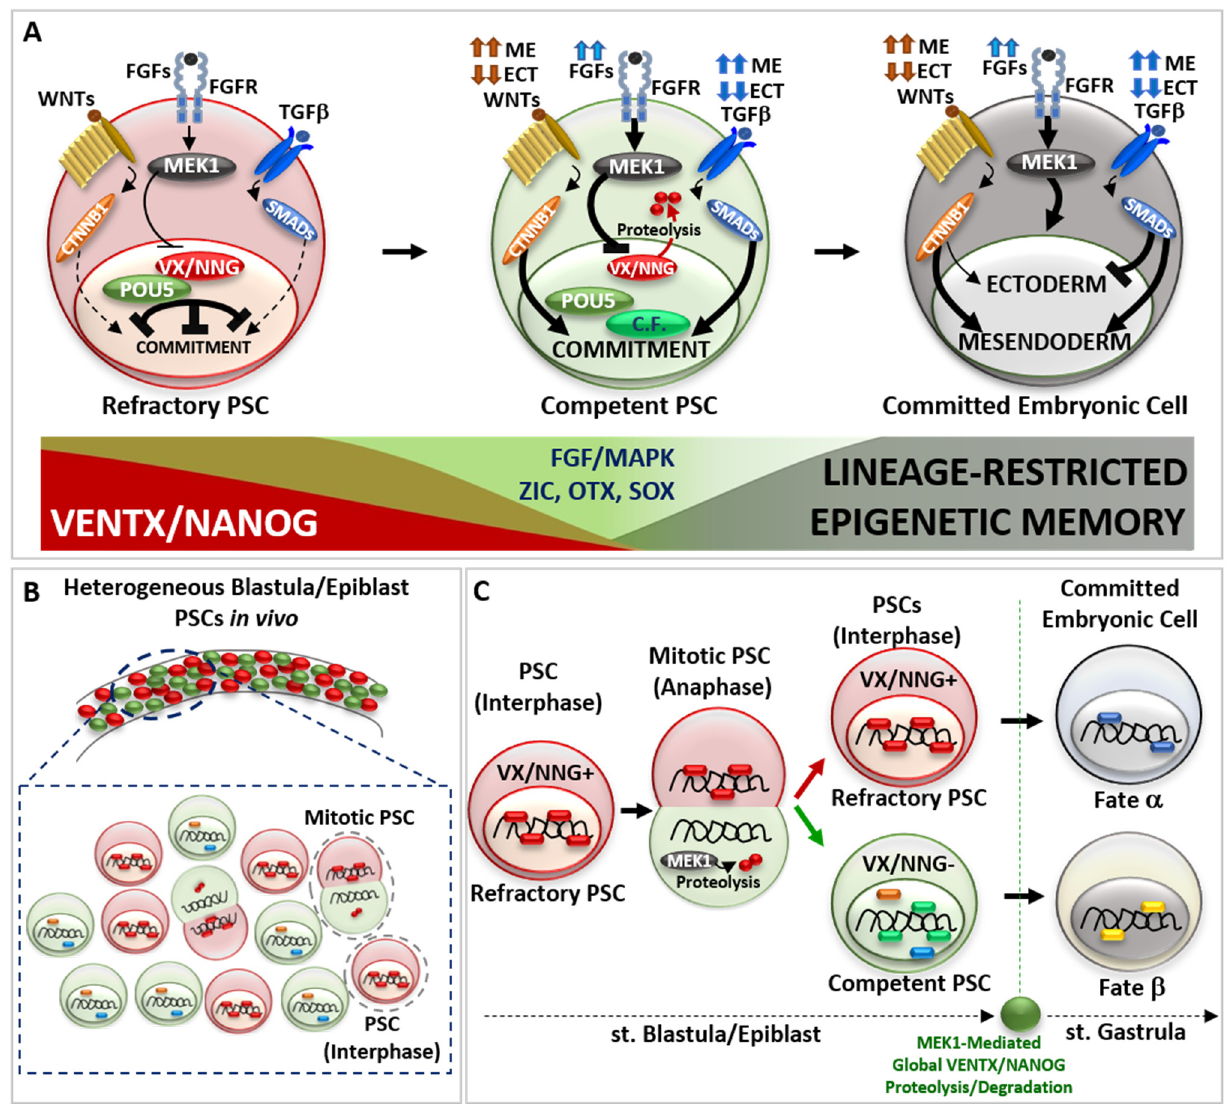
Figure 2. The continuum of cell potency in vivo. ( A ) Schematic representation of pluripotent stem cell (PSC) transition from a refractory (red cell) to a competent (green cell) state and further germ- layer specific embryonic cell commitment (dark cell). Refractory PSC displays high activity of VENTX/NANOG—POU5/OCT4 heterodimer, which counteract the activity of pro-differentiating cues (extracellular ligand TGF β , WNT signalling pathways) and cell commitment. Once increasing MEK1 kinase, acting down-stream of the FGFs signal (indicated by blue arrows), destabilise VENTX/NANOG—POU5/OCT4 heterodimer through VENTX/NANOG proteolysis, competent PSCs can interpret and respond to pro-differentiating cues (TGF β , WNT), thus entering into com- mitment through new interactions between POU5/OCT4, Competence factors (C.F., light green) and pro-differentiating intracellular effectors (CTNNB1, SMADs). Note that the high or low intensity of pro-differentiating signal (TGF β /SMADs indicated by dark blue arrows, WNT/CTNNB1 indicated by brown arrows) instruct competent PSCs to commit to a germ layer specific cell fate, which is realized once PSCs exit from pluripotency and enter into embryonic cell commitment (dark cell). On the bottom: schematic representation of VENTX/NANOG activity in PSCs (in red, high in re- fractory PSCs, low in competent PSCs) compared to FGF/MAPK and Competence factors (i.e., ZIC, OTX, SOX) (in green, low in refractory PSCs, high in competent PSCs) and the appearance of line- age-restricted epigenetic memory (in dark, absent in refractory PSCs and increased in competent- to-committed embryonic cells). ( B ) Schematic representation of refractory to competent PSC transi- tion in vivo. In vertebrate blastula/epiblast, mitotic PSCs divide asymmetrically and generates one refractory daughter PSCs (red cell) and one competent daughter PSC (green cell). ( C ) Mitotic blas- tula/epiblast PSC show asymmetric distribution of VENTX/NANOG (VX/NNG) protein at